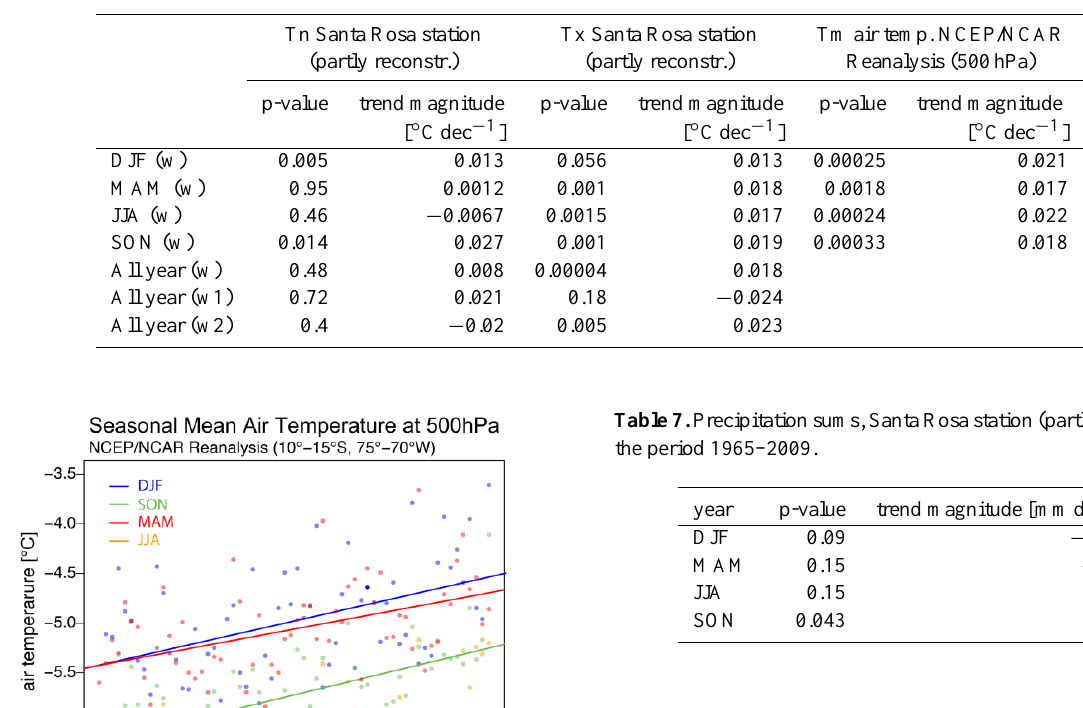
Table 6. Trend magnitude per decade and p-value for seasonal and annual monthly minimum, maximum and mean air temperature for the